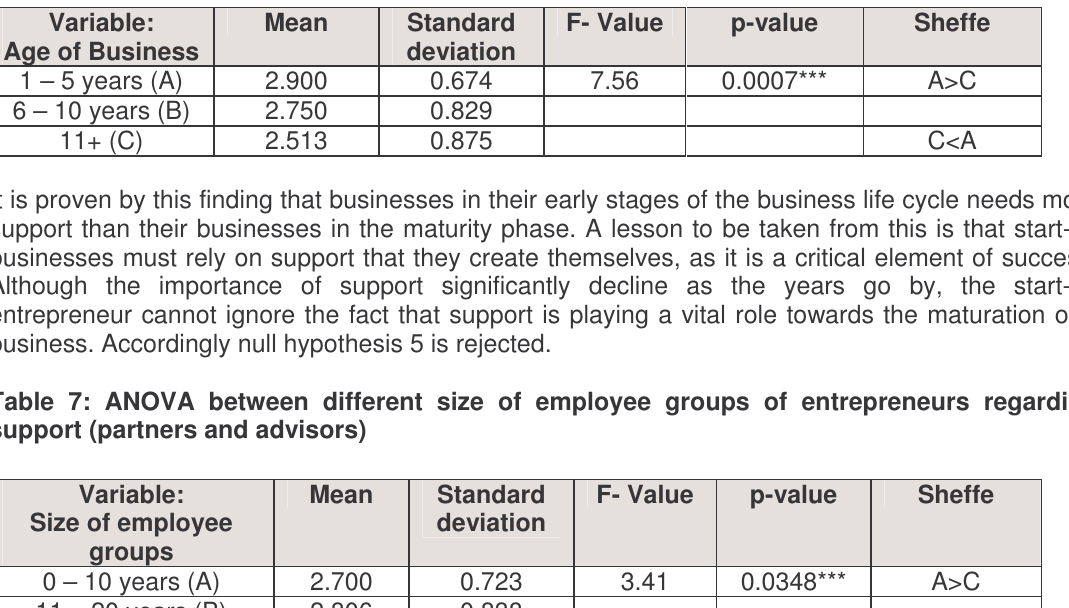
Table 6: ANOVA between different starting dates (age of business) regarding support (partners and advisors)